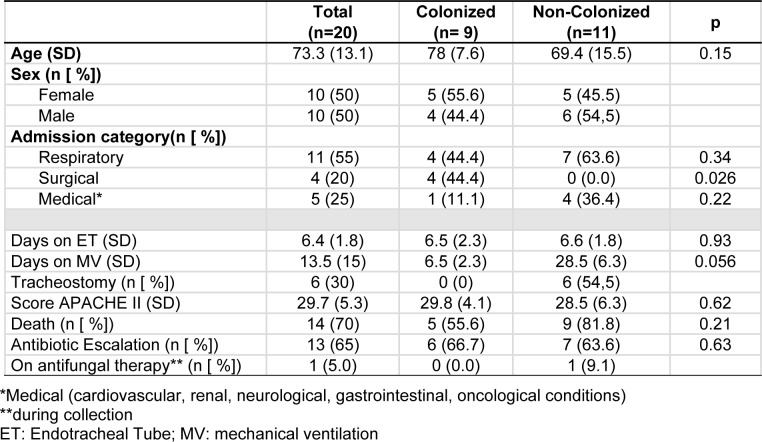
Patient details